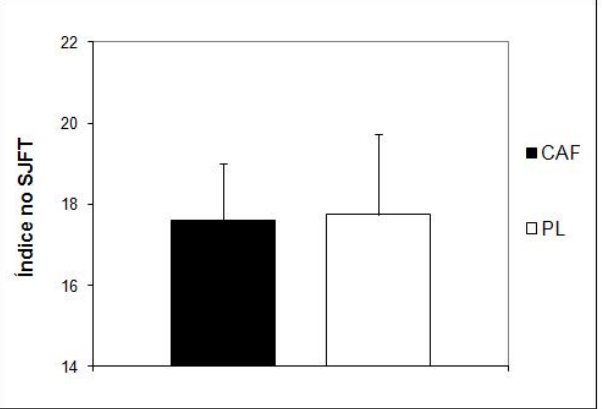
Figura 4. Índice de desempenho alcançado no Special Judo Fitness Test